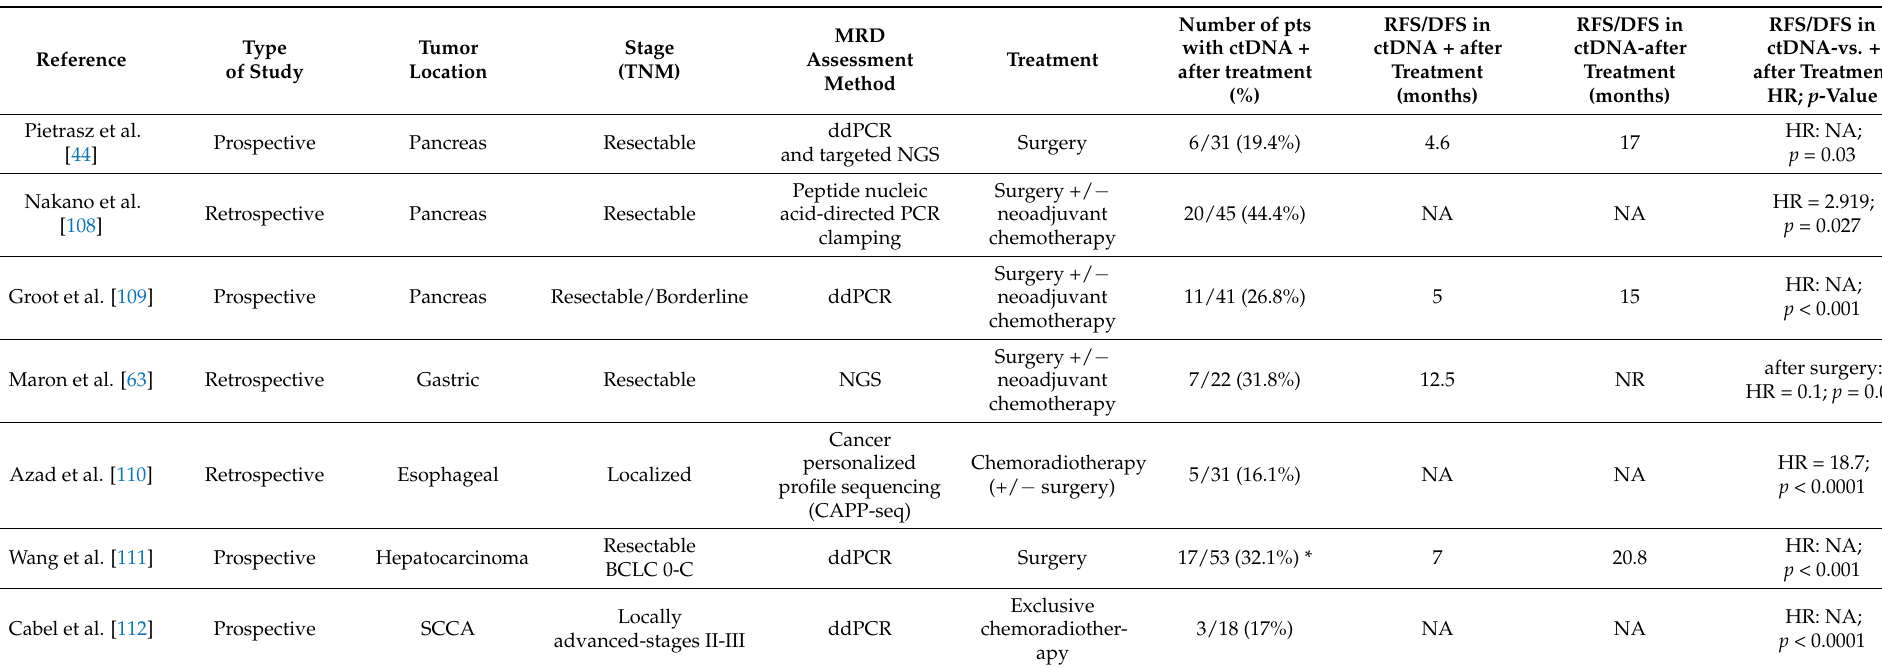
Table 2. Main Minimal Residual Disease assessment studies for circulating tumor DNA in gastro-intestinal cancers except